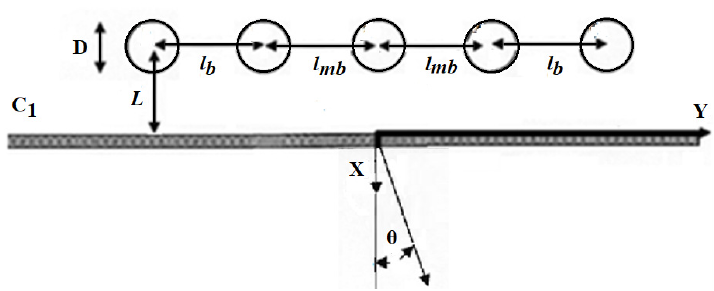
Figure 13. Examined WEC array configuration placed in parallel arrangement to the wall.